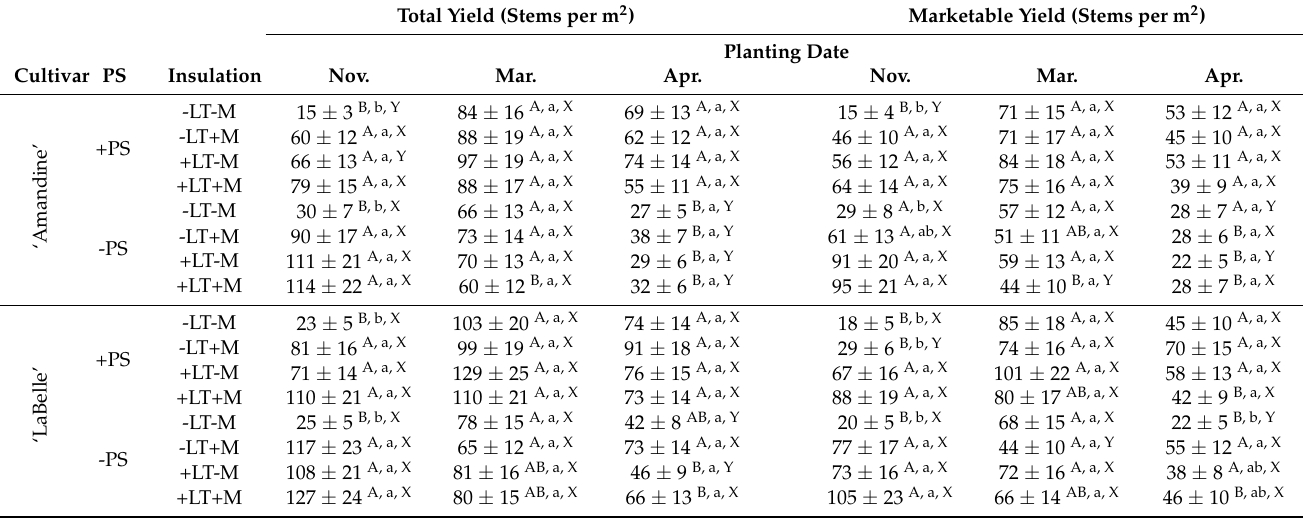
Table 1. Field ranunculus production by calculated mean( ± SE) total and marketable yields in stems per m 2 by cultivar (‘Amandine’ and ‘LaBelle’), pre-sprouting (pre-sprouted +PS and nonpre-sprouted -PS), insulation (no insulation -LT-M, mulch -LT+M, low tunnel +LT-M, and low tunnel and mulch +LT+M), and planting date (Nov., Mar., and Apr.) in North Logan, UT over 2020–21 and 2021–22. Total Yield (Stems per m 2 ) Marketable Yield (Stems per m 2